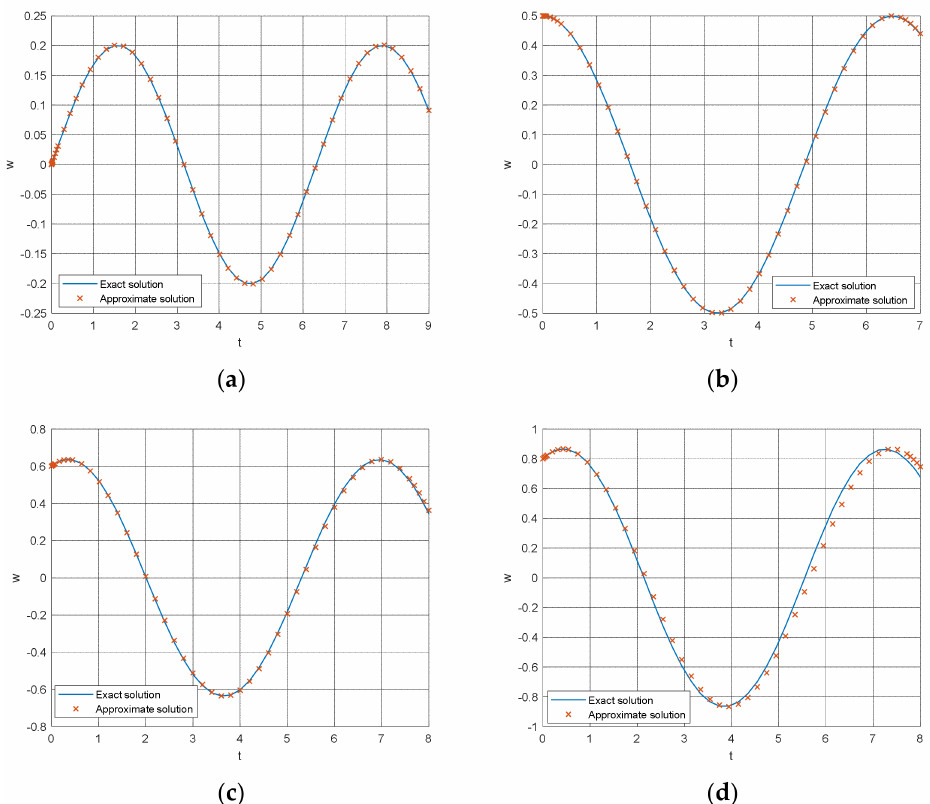
Figure 2. The approximate solution ( w = A cos ( ω t + ϕ ) ) vs. the exact one of Equation (27). ( a ) ( a,b ) = (0, 0.2); ( b ) ( a,b ) = (0.5, 0); ( c ) ( a,b ) = (0.6, 0.2); and ( d ) ( a,b ) = (0.8,